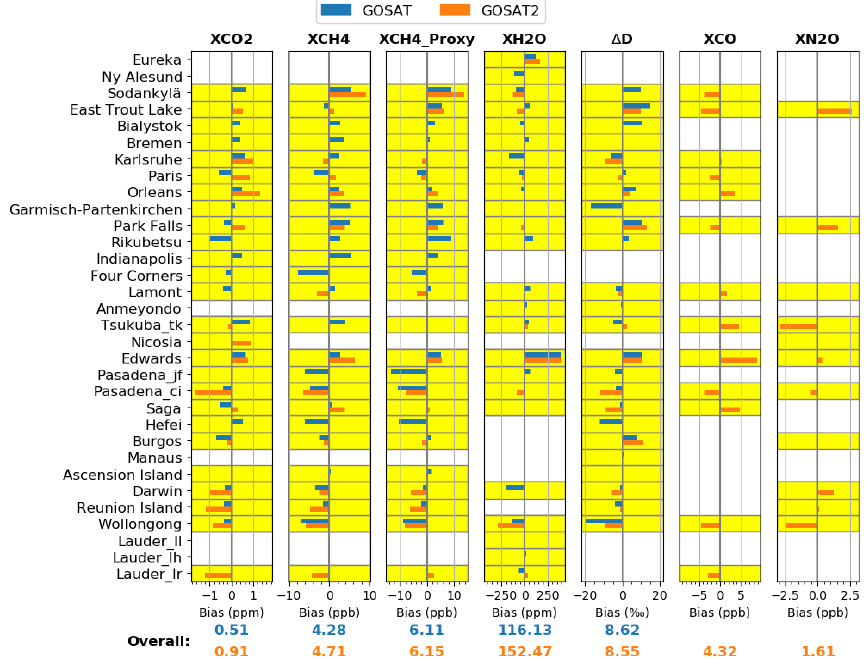
Figure 13. Bias of FOCAL data products for GOSAT (blue) and GOSAT-2 (orange) at different TCCON stations. Involved stations for each product are marked by a yellow background. Note that small biases (close to zero) may not be visible in the plot. The mean station bias has been subtracted to better illustrate the local station differences. See Table 6 for a summary of all TCCON validation results.